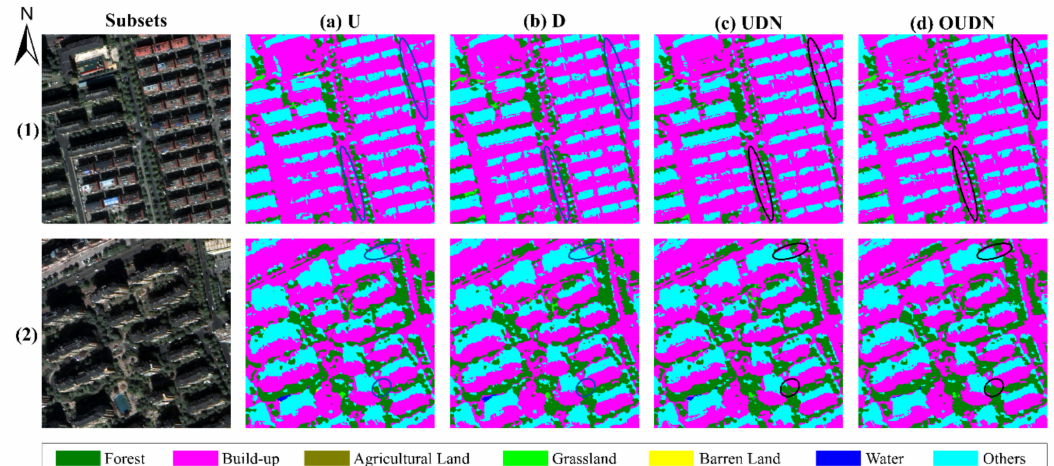
Figure 11. There are two subsets (Subset ( 1 ) and Subset ( 2 )) dominated by urban forests. ( a ) the classification maps of the U algorithm in the subsets; ( b ) the classification maps of the D algorithm in the subsets; ( c ) the classification maps of the UDN algorithm in the subsets; and ( d ) the classification maps of the OUDN algorithm in the